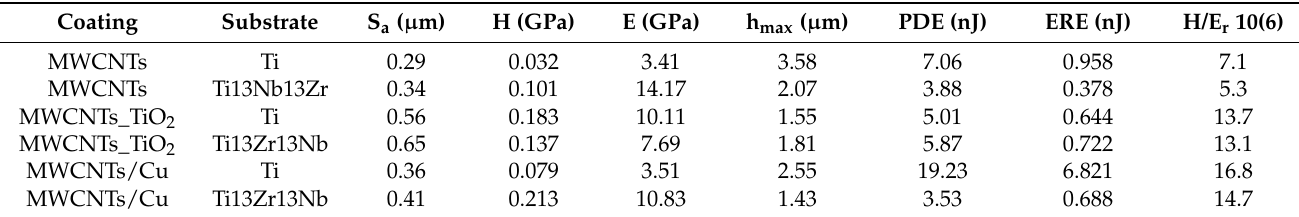
Table 4. Comparison of mechanical properties of two coatings deposited on different substrates: Ti (present work) and Ti13Nb13Zr (previous research